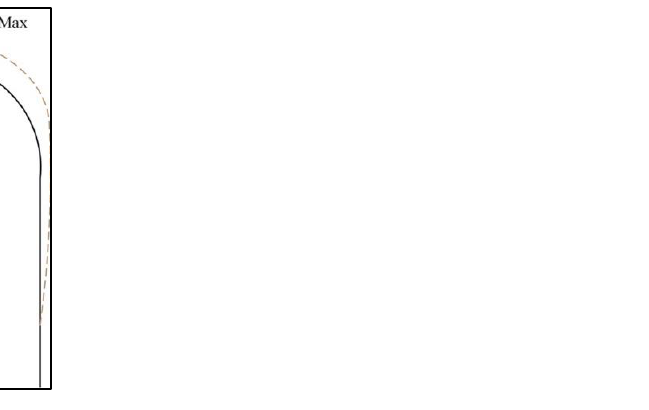
Figure 13. Performance measures relating to the space required for headland turning (in the case of a left turn). Table 1. Headland turning performance comparison.